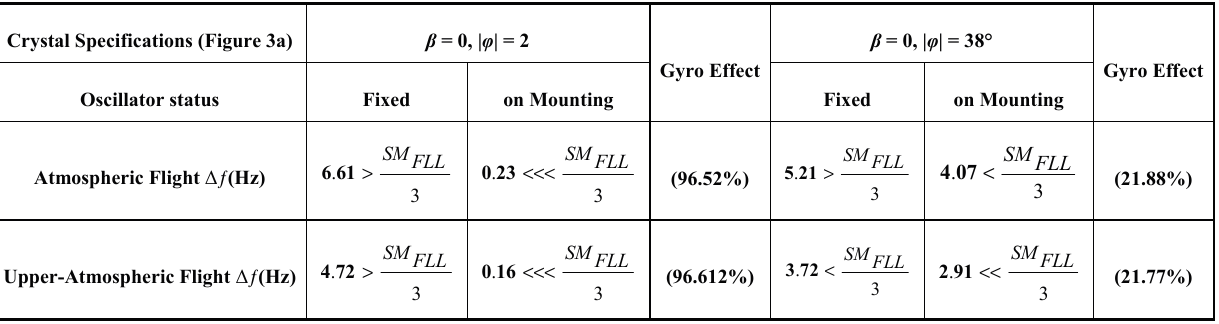
Figure 11. Maximum disturbances caused by steady-state acceleration. ( a ) Frequency deviation of a fixed oscillator; ( b ) Frequency deviation of the gyroscopic mounting; ( c ) Phase deviation of a fixed oscillator; ( d ) Phase deviation of the gyroscopic mounting. Table 1. Gyroscopic mounting effect on steady-state load-induced disturbances on FLL for the most probable